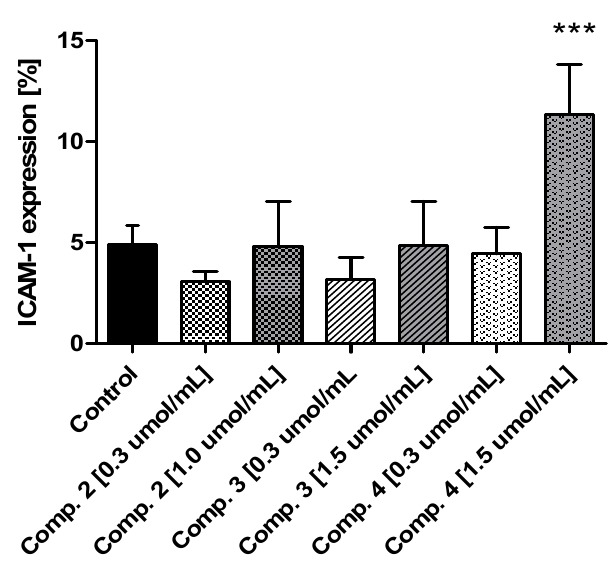
Figure 5. The e ff ect of metformin and its derivatives on ICAM-1 expression on AoSMCs. ( A ) Flow cytometry analysis of the expression of ICAM-1 on the surface of AoSMC cells. Representative histograms of unstimulated AoSMC cells (control–CD54 [CTR] and isotype control [CTR-isot]) and cells treated with metformin (1.5 µ mol / mL). Cytograms on the left side: forward and side scatter plot of AoSMC cells. The living cells were marked with gate A. Cytograms on the right side: percentage of single cells expressing ICAM-1. ( B ) The e ff ects of compounds 1 – 4 administered at the highest concentrations on the percentage of the surface ICAM-1 expression (representative histograms). ( C ) The summary of e ff ects of metformin, and compounds 1 – 4 on ICAM-1 expression ( n = 3–6), mean ± SD;* p < 0.05; ** p < 0.01; *** p < 0.001. Two-way Anova analysis revealed significantly greater ICAM-1 expression on AoSMC cells surface in the case of compound 4 at the concentration 1.5 µ mol / mL.